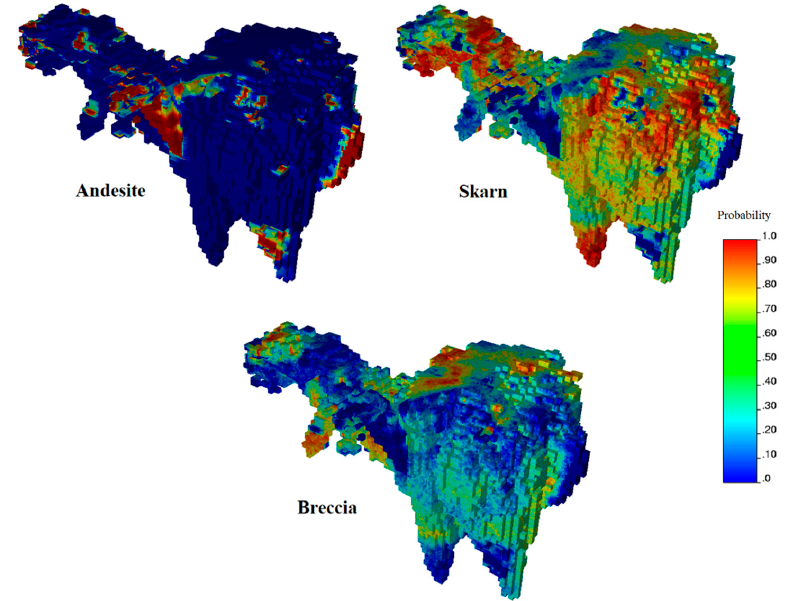
Figure 5. Probability maps of the different rock types, calculated on the basis of 100 plurigaussian realizations.